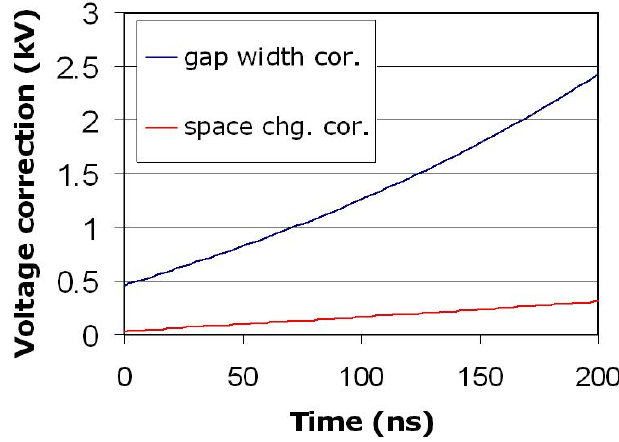
FIG. 12. (Color) Optimized IBM voltage correction (cid:1) V (cid:6) t (cid:8) for finite gap width and space charge for the NDCX beam with b (cid:5) g (cid:5) 4